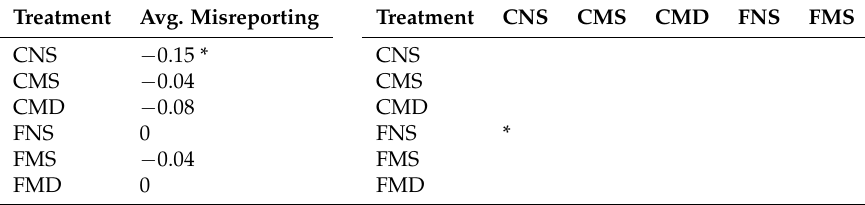
Table A6. Misreporting of Type H Patients across Experimental Conditions.